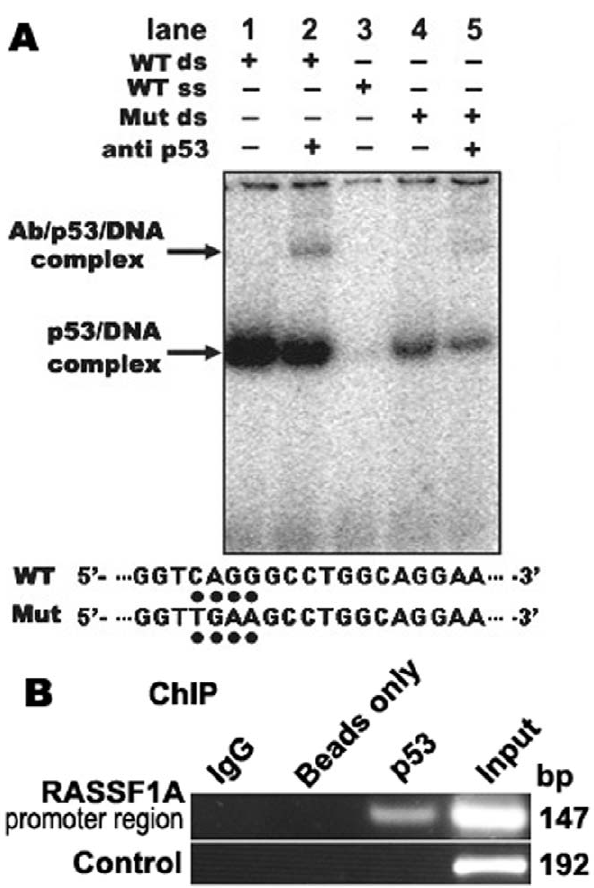
Figure 3. p53 protein binds to the RASSF1A promoter. A , EMSA analysis of p53 binding to the RASSF1A promoter. WT, the wild type p53 binding site probe from human RASSF1A promoter; Mut, mutant p53 binding site probe; ds, two complementary oligonucleotide probes; ss, single stranded probe. The supershift band in lane 2 contains the anti- p53/wt DNA/p53 protein complex. Complexes were separated by native gel electrophoresis. Mutant sequence was showed in lower panel. B , ChIP assay of p53 binding to the RASSF1A promoter in Siha cells. Samples of sonicated chromatin from Siha cells cross-linked in 1% formaldehyde were immunoprecipitated with anti-p53 antibody, preimmuno IgG (IgG) and no antibody (beads only). DNA isolated from immunoprecipitated material was amplified by PCR with primers to amplify the 147 bp RASSF1A promoter sequences flanking the p53 binding site ( 2 2799 bp to 2 2653 bp). A region of 192 bp flanking amplified PCR fragments were analysed on 2% agarose gel.